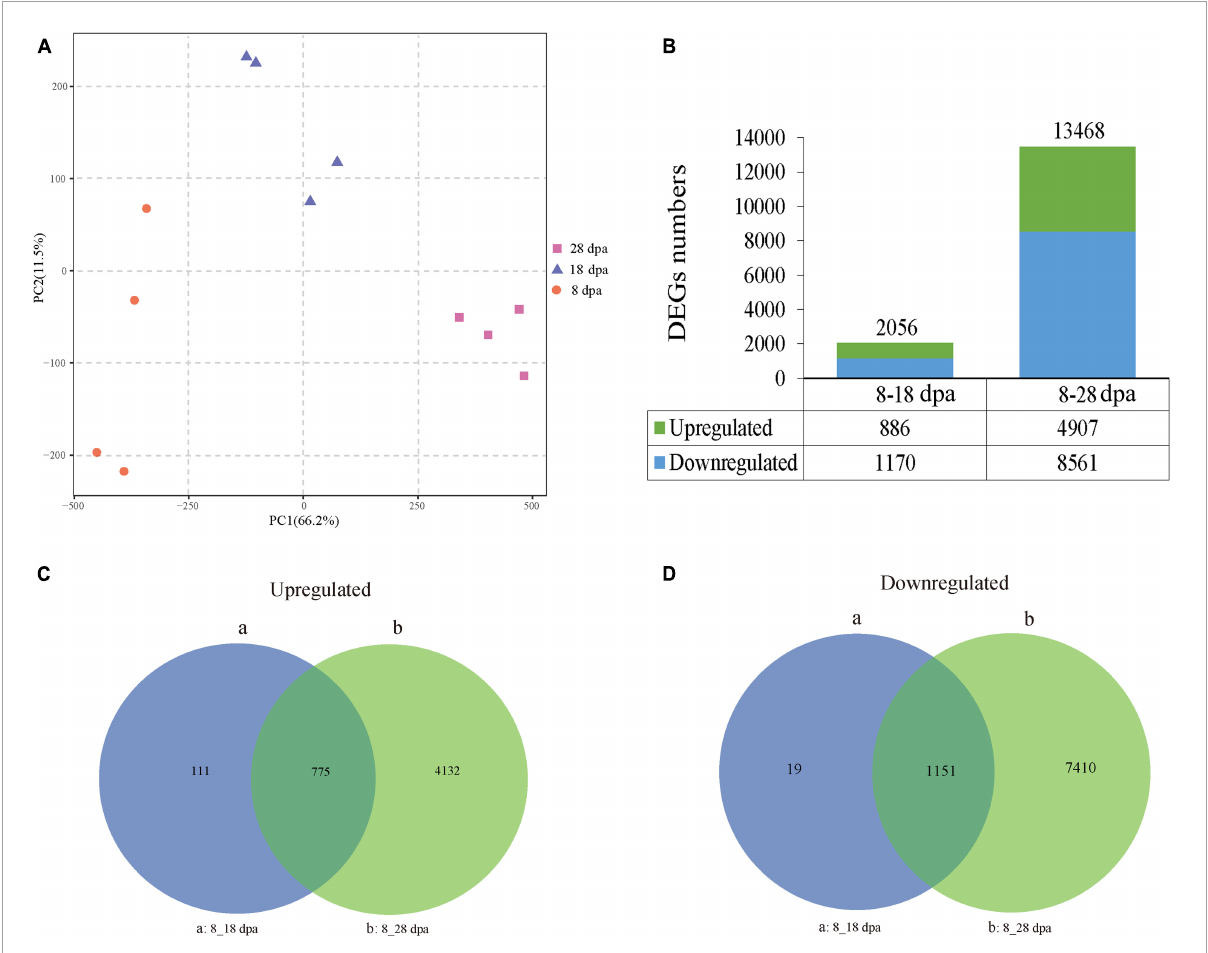
FIGURE6 PCA and DEGs during seed development. (A) PCA was first used to obtain an overview of RNA-seq of the 8, 18, and 28 dpa conditions. Different plots represent combinations of the first and second principal components (PC1 and PC2). The proportions of explained variance are shown in brackets. (B) Numbers of DEGs at 8–28 dpa. The upper and lower parts of each bar represent upregulated and downregulated genes. The total numbers of DEGs are located at the top of the bar in each group. The numbers of up- and downregulated expressed genes are listed at the bottom of the figure. (C,D) Venn diagrams show the number of DEGs across three comparisons. (a,b) Show the comparisons of different unigenes identified between 8 dpa vs. 18 dpa and 8 dpa vs. 28 dpa, respectively.